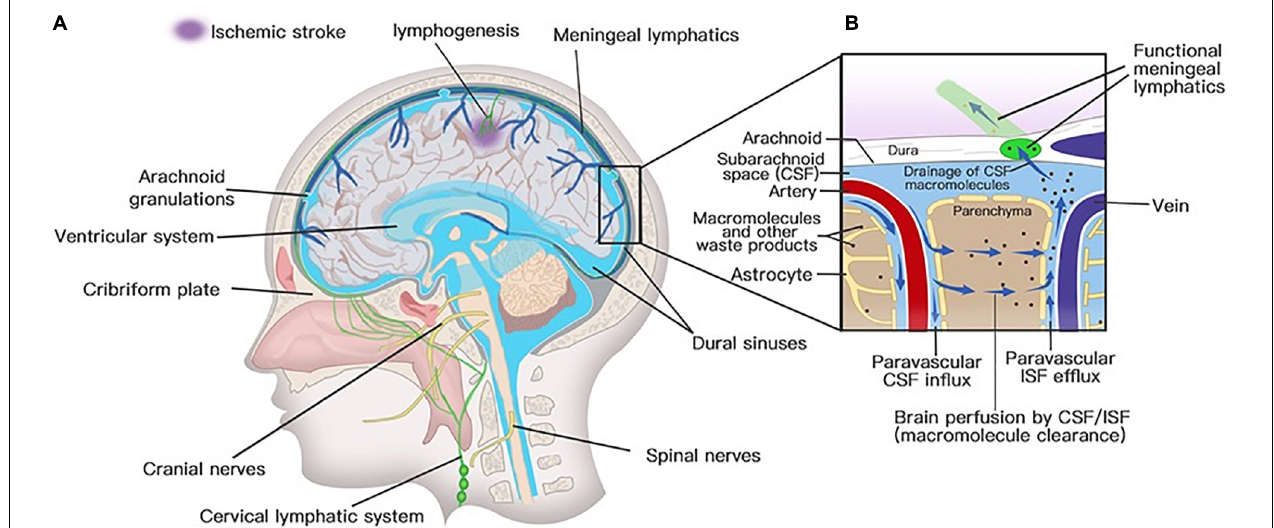
FIGURE 3 | Lymphatic drainage system in the brain. (A) Meningeal lymphatic vessels run down toward the base of the skull along the sinus, the vein, and the meningeal arteries and drain out of the skull via the foramina of the base of the skull alongside arteries, veins, and cranial nerves. Meningeal lymphatic cells grow into the injured brain parenchyma induced by photochemical thrombosis. (B) Cerebrospinal fluid (CSF) enters the parenchyma by bulk flow along paravascular spaces, and ISF is cleared along paravenous drainage pathways. Meningeal lymphatic vessels absorb CSF from the adjacent subarachnoid space and ISF from the glymphatic system and transport fluid into deep cervical LNs (dcLNs) via foramina at the base of the